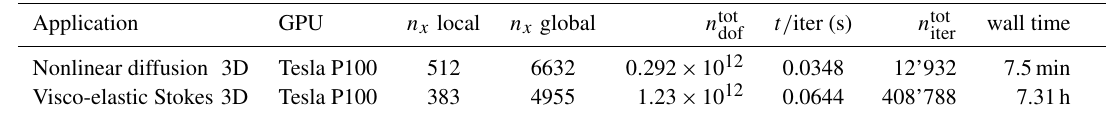
Table 2. Wall-time prognostic for resolving the nonlinear diffusion and the visco-elastic Stokes 3D Julia multi-GPU applications on 2197 (13 3 ) Nvidia Tesla P100GPUs on the Piz Daint supercomputer at